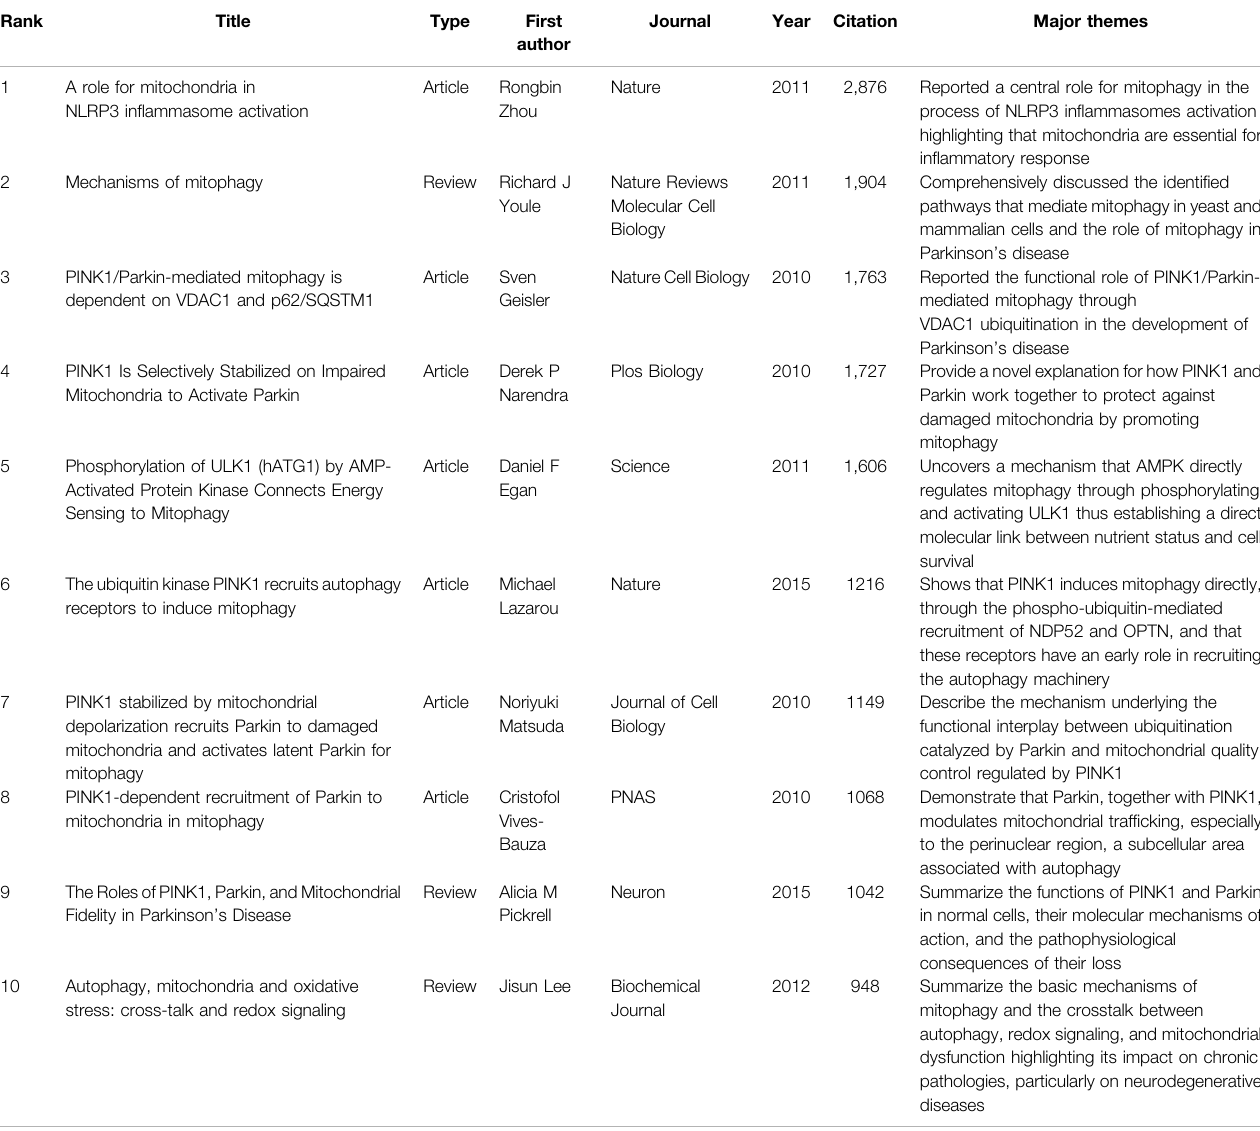
TABLE 4 | Top 10 mitophagy-related publications with the most citations (up to 13 December